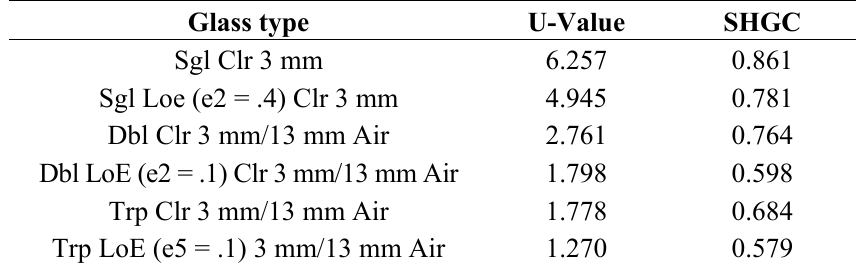
Table 3. Glass type for test set.